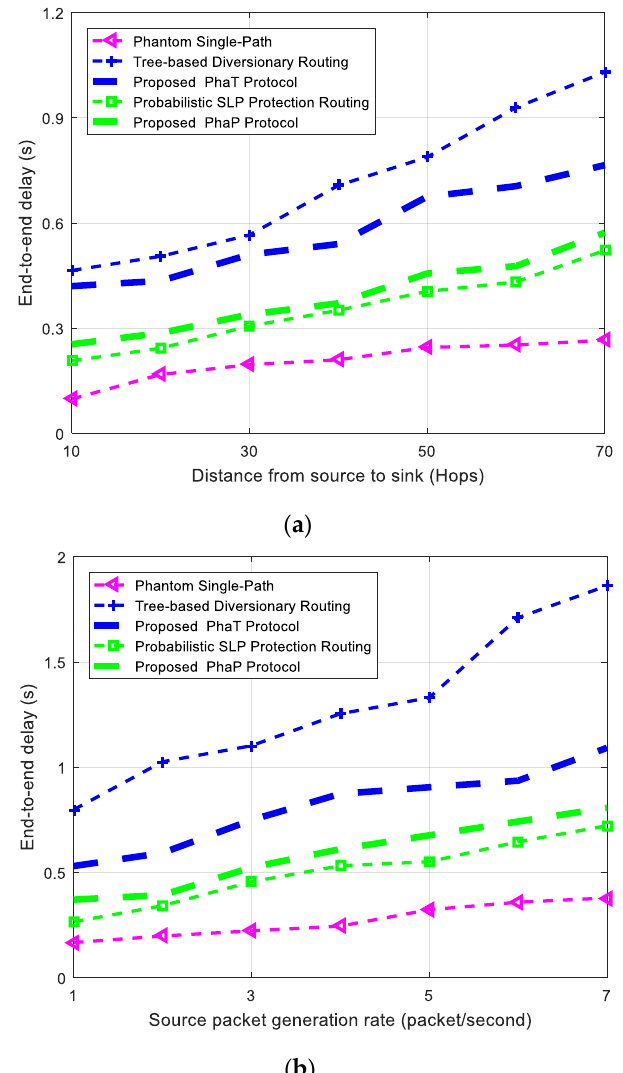
Figure 9. End-to-end delay (EED) of the protocols. ( a ) EED against varied source–sink distance. ( b ) EED against varied source packet rate.